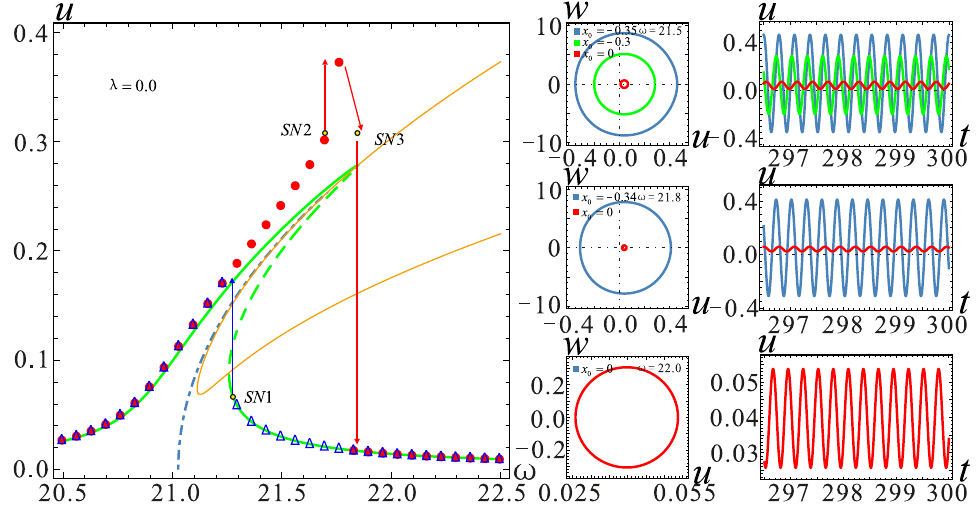
Figure 11. Phase diagram and the corresponding time history curve at λ = 0. The solid lines represent stable solutions. The dashed lines represent unstable solutions. The point represents the numerical solution.